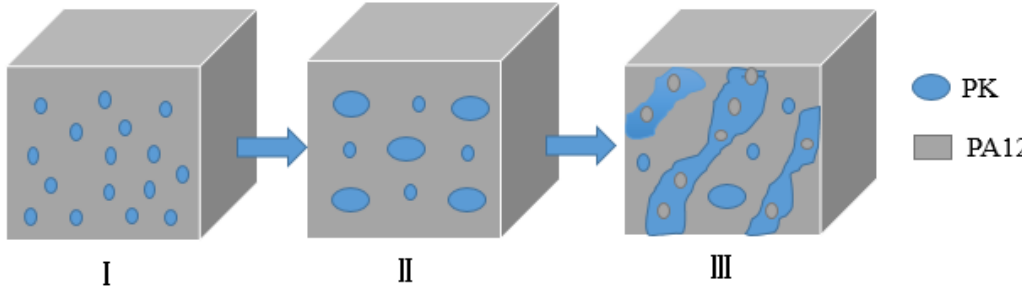
Figure 3. The morphology evolution of PA12/PK blends with an increasing content of PK. ( I )Nano- dispersion of PK in PA12 matrix; ( II ) submicron- and nanoscale dispersion of PK in PA12 matrix;